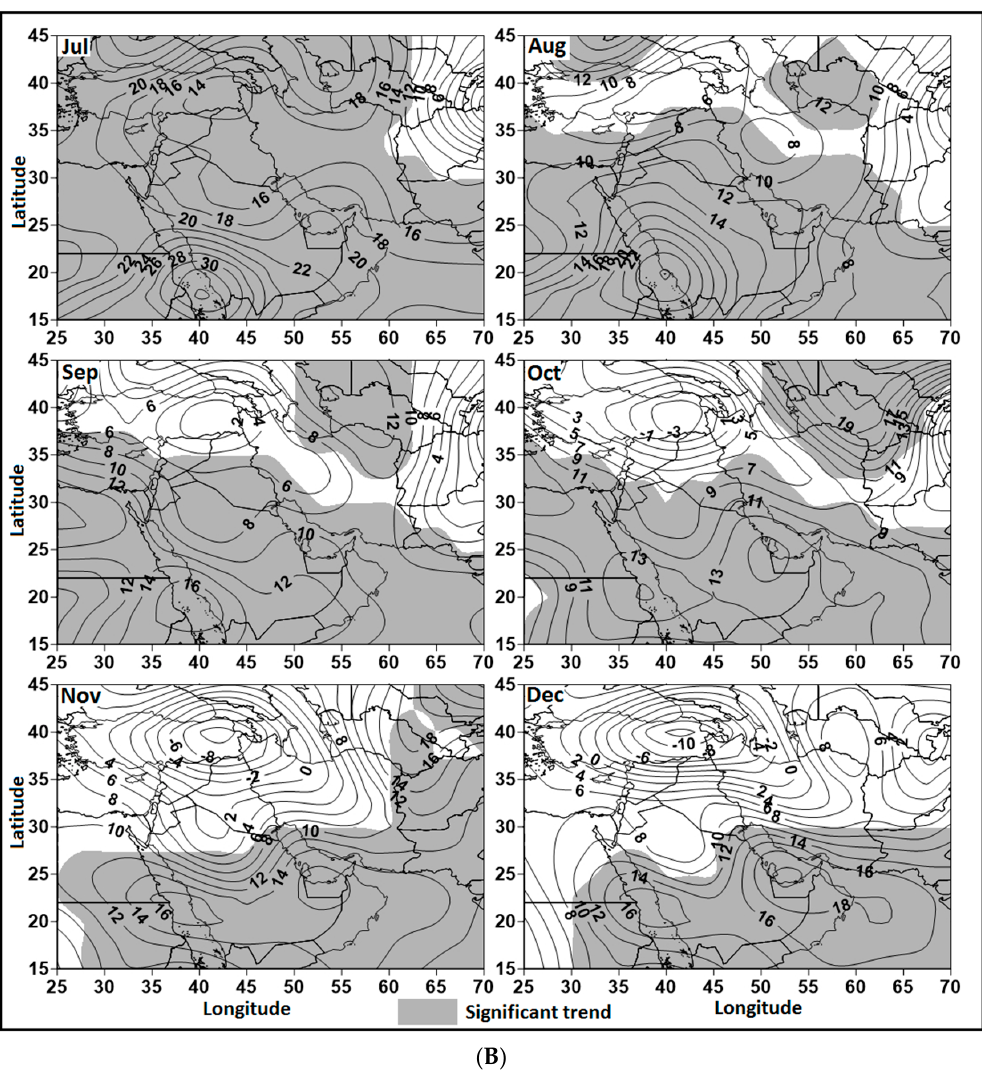
Figure 3. ( A ) Spatial distribution of Iran’s monthly trend, AT and level of significant; ( B ) Spatial distribution of Iran’s monthly trend, AT and level of significant. Table 3. Area (%) covered by AT in Iran and the Middle East (In this table: Decr = Decreasing, Incr = Increasing).